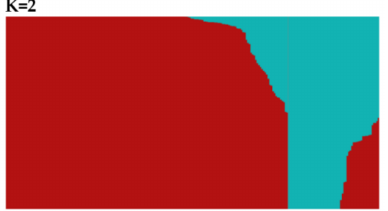
Figure 2. Population structure analysis of G. soja